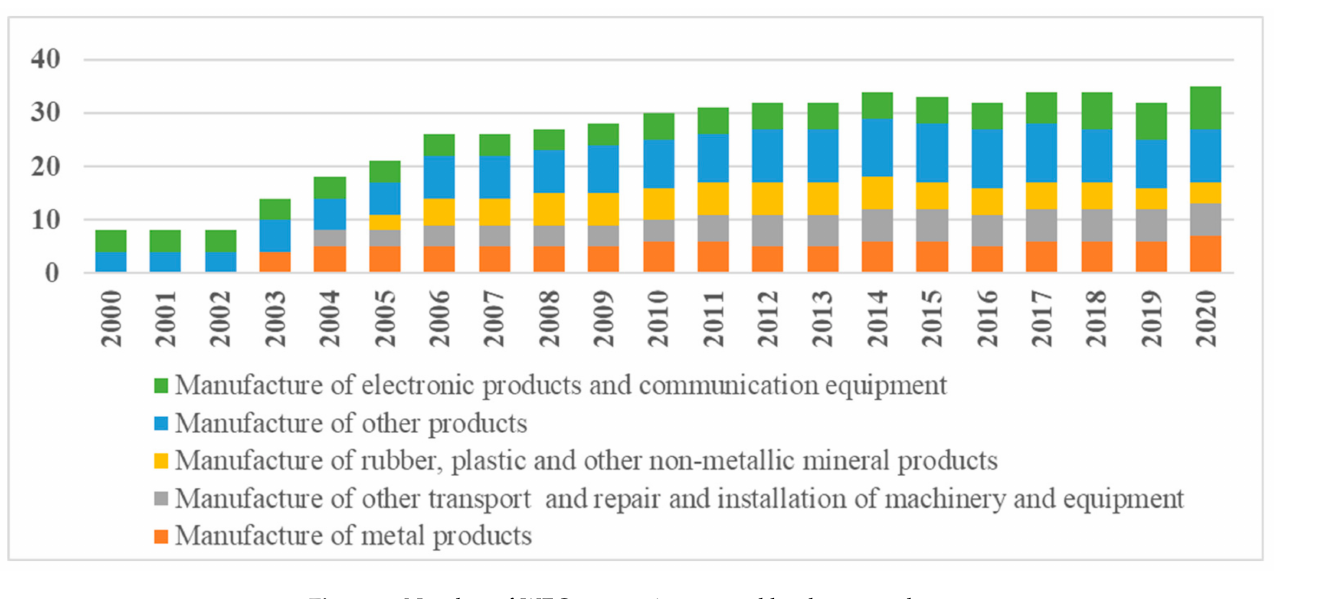
Figure 1. Number of WEC companies covered by the